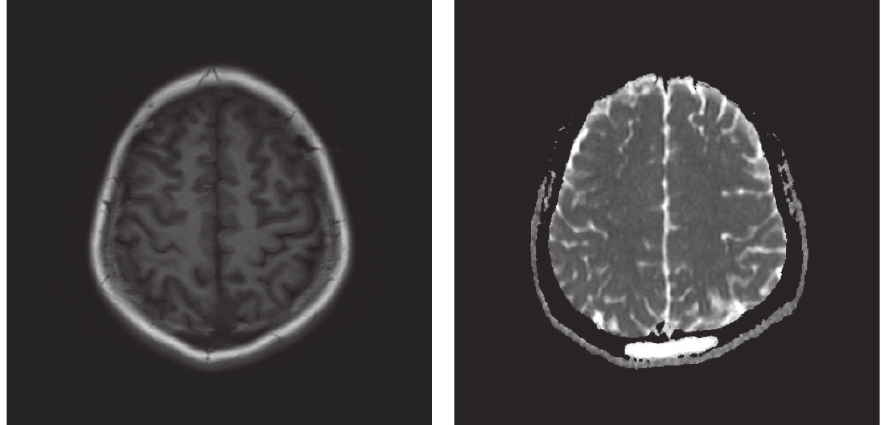
Figure 1: Abnormal signal of the occipital scalp.